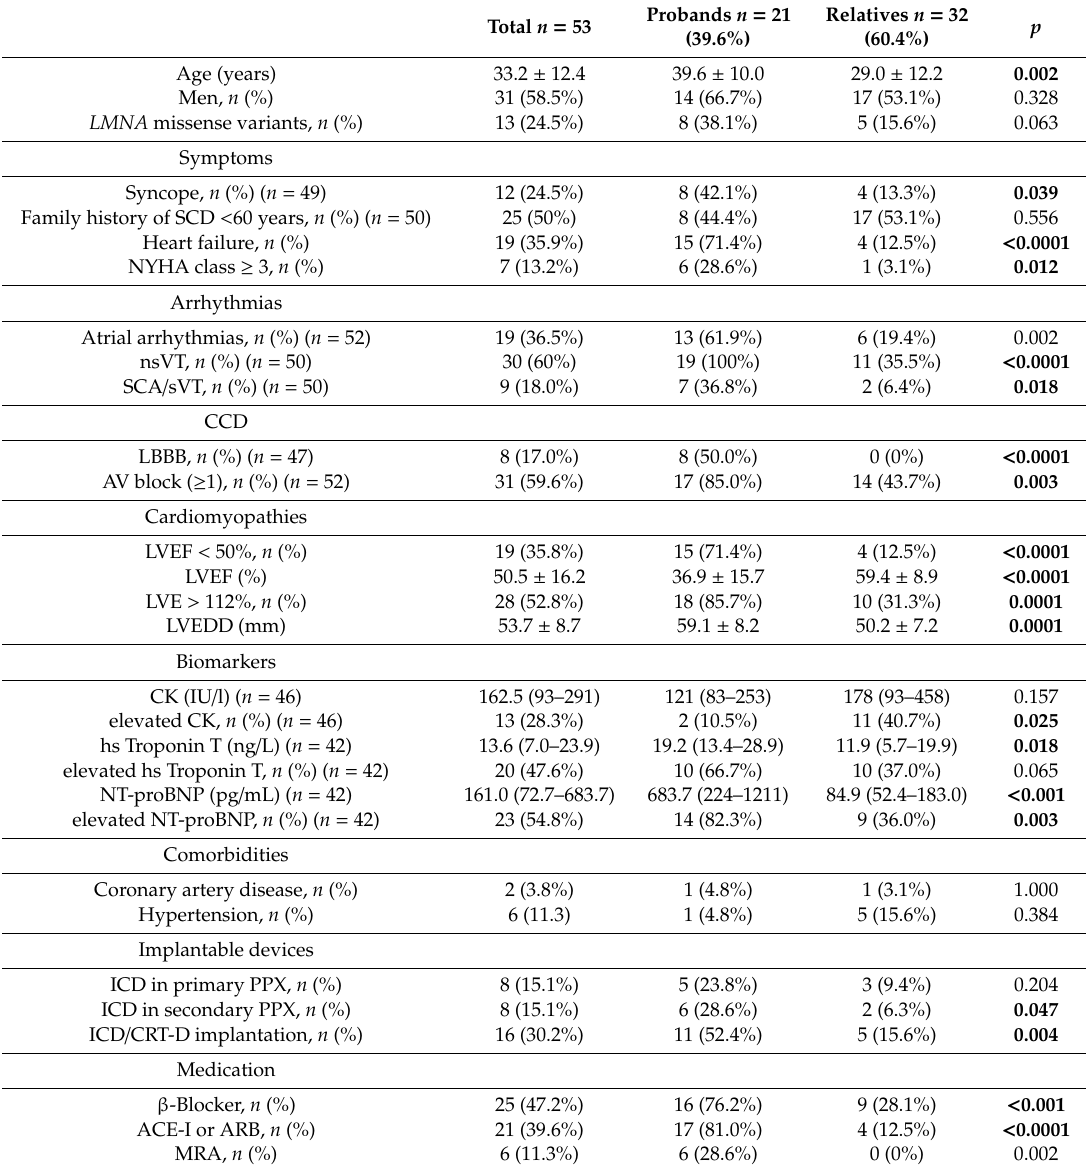
Table 2. Baseline clinical characteristics of LMNA variant carriers at initial